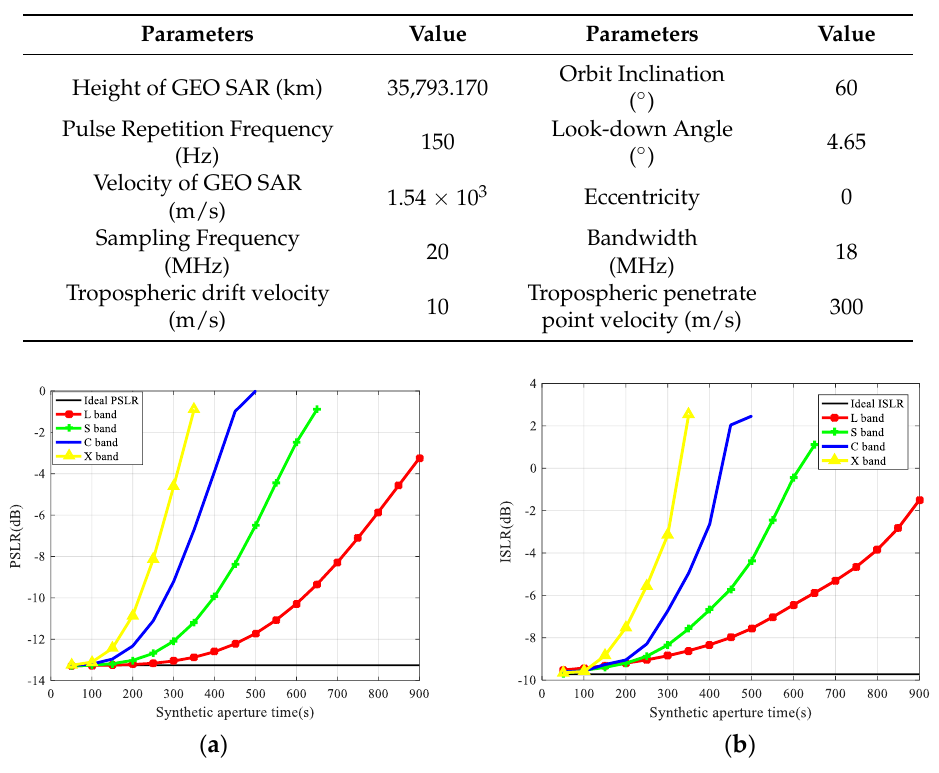
Figure 3. Assessment of impacts on GEO SAR imaging of troposphere at different wavelengths and integration times (Red: L-band; green: S band; blue: C band; black: X band). ( a ) Peak sidelobe ratio (PSLR). ( b ) Integral sidelobe ratio (ISLR). Table 3. Evaluations of point target imaging of GEO SAR with different orbital configurations at different wavelengths (P: perigee; E: equator; H: high-inclination; L: